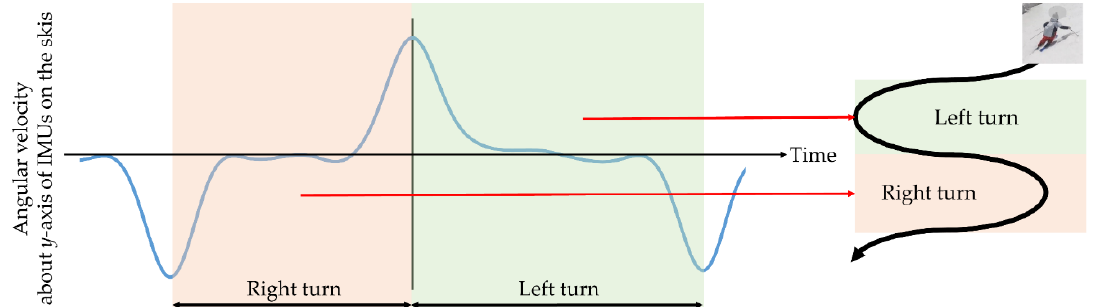
Figure 4. The change in angular velocity about the y -axis, indicating edge speed, of an inertial sensor installed on the skis was used to define one turn. In this experiment, right turns were defined as the interval from negative to positive peaks, and left turns were defined as the interval from positive to negative peaks.